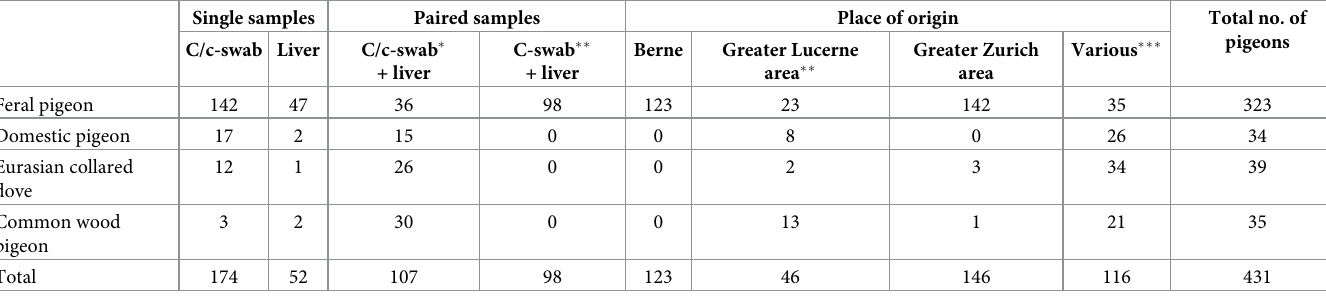
Table 1. Number of pigeons according to type of pigeon, sample material and place of origin. Single